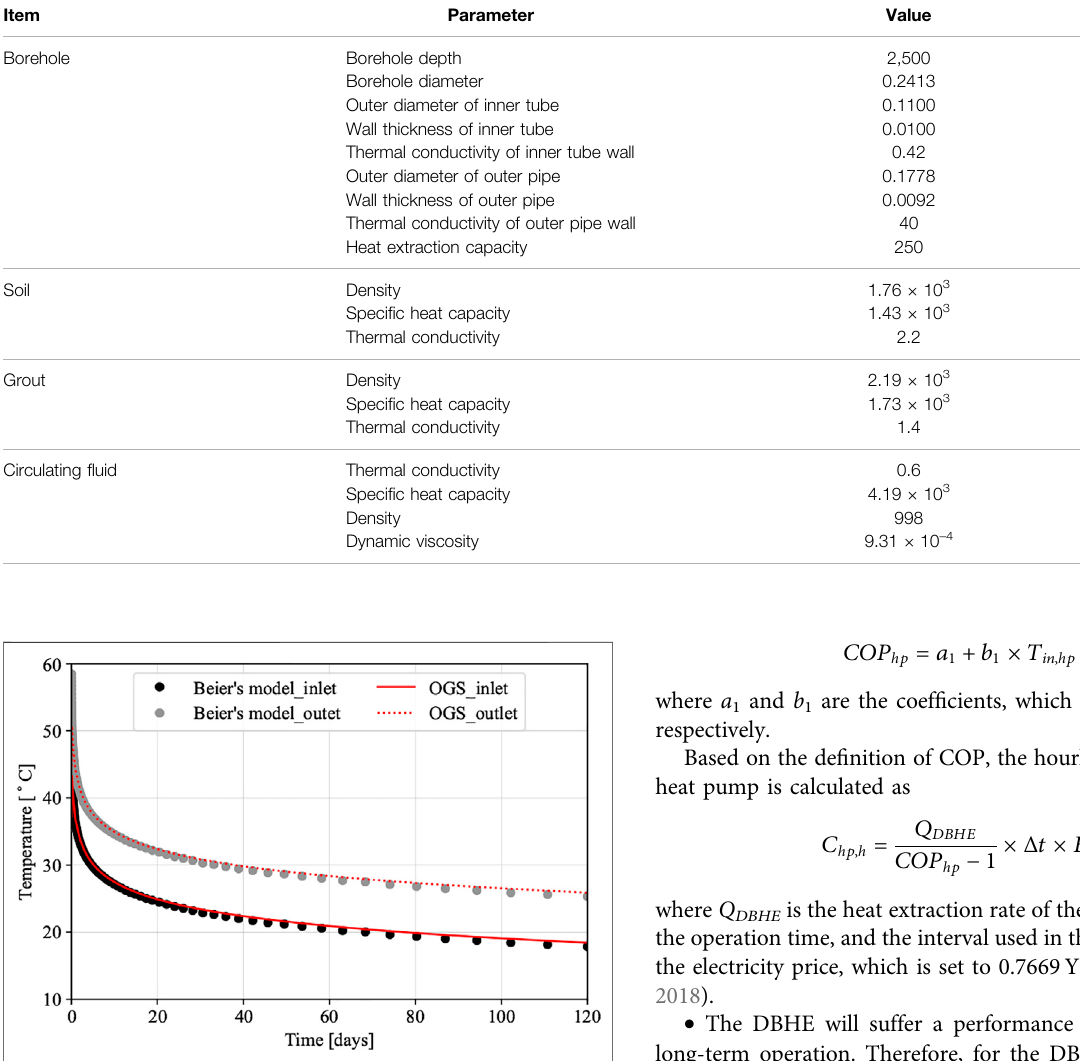
FIGURE 2 | Veri fi cation of the proposed DBHE model based on OpenGeoSys against Beier ’ s analytical solution.